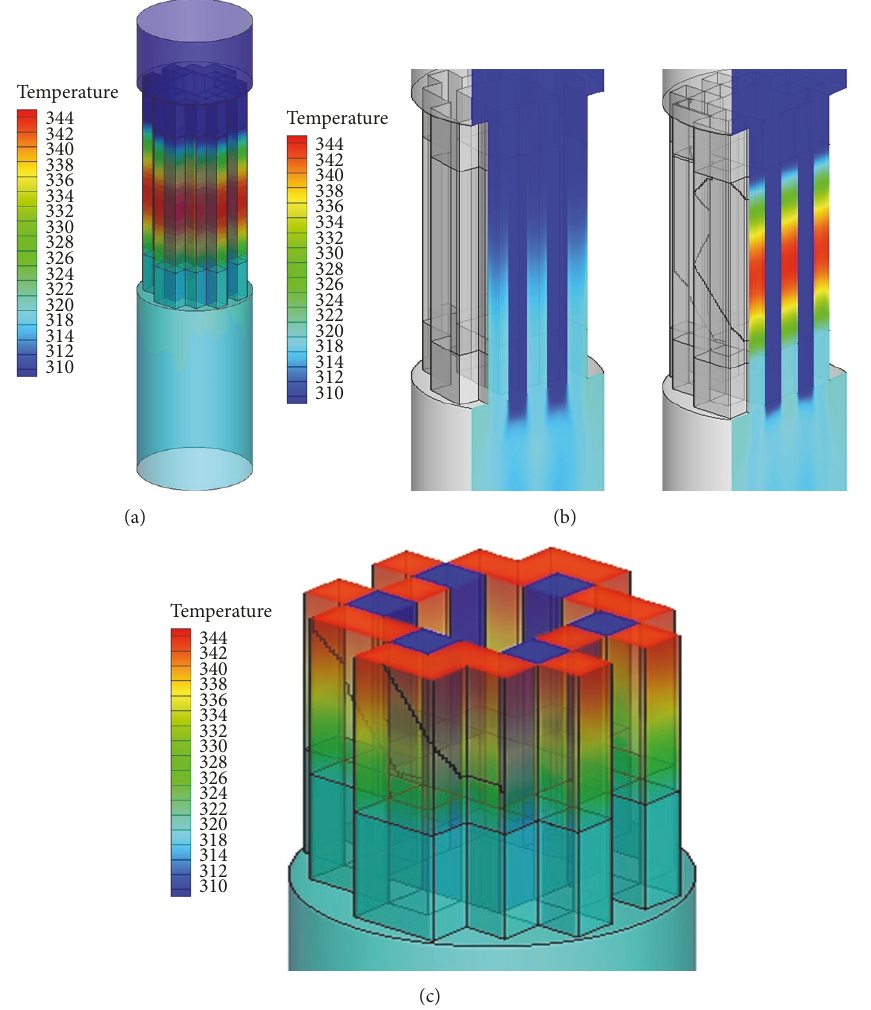
Figure 9: Temperature contours predicted by the thermal nonequilibrium model: (a) whole calculation region, (b) vertical cross sections for coolant (left) and fuel (right) temperatures, respectively, and (c) fuel transverse cross section with the peak